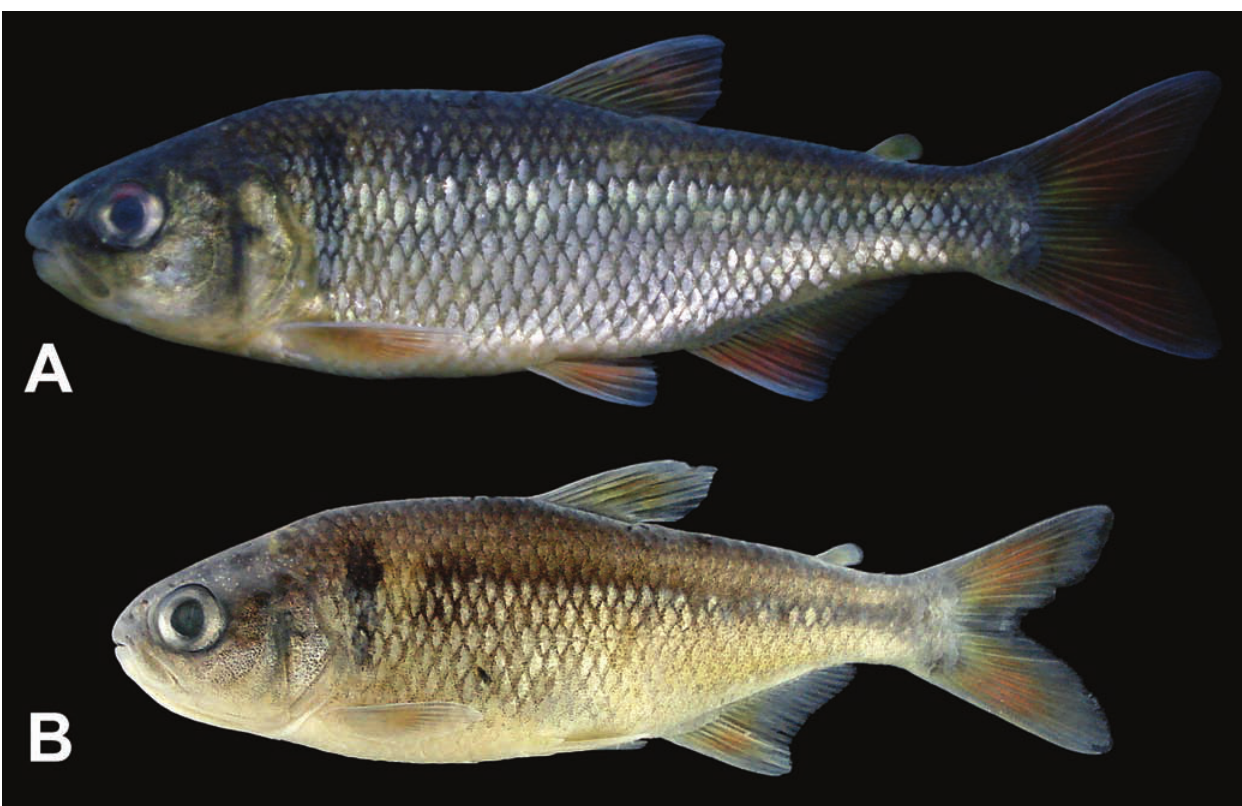
Fig. 1. Astyanax eremus , new species. A: Holotype, MNRJ 39677, 94.0 mm SL; B: Paratype, MCP 46942, 59.9 mm SL. All from the rio Canivete, Balsa Nova, Paraná State,